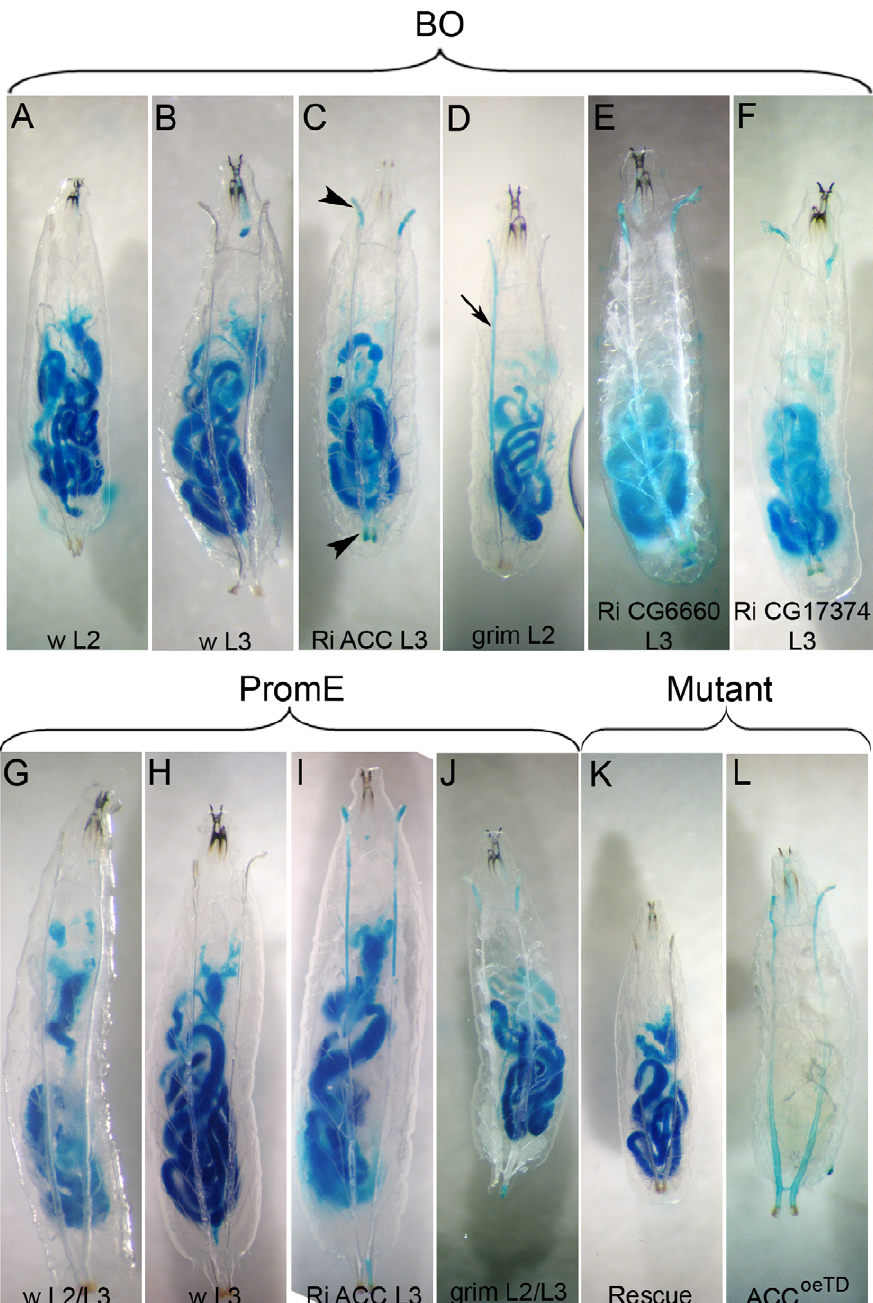
Figure 5. Water-tightness defect of the spiracles. (A–L) Tests for liquid entry into the tracheal system after transfer of larvae onto a semi-liquid media stained with Brilliant Blue FCF. Control larvae were maintained for 36 h inside the tinted feeding medium and analyzed at various times (A,B,G,H,K) Mutant larvae without any visible tracheal defect were transferred onto the tinted feeding medium and analyzed as they strayed away (C,D,E,F,I,J,L). Larvae of the following genotypes and stages: (A) BO control late L2, (B) BO control early L3, (C) BO . ACC-RNAi early L3, (D) BO . grim late L2, (E) BO . CG6660-RNAi early L3, (F) BO . FAS CG17374 -RNAi early L3, (G) promE control at the L2/L3 transition, (H) promE control early L3, (C) promE . ACC-RNAi early L3, (D) promE . grim at the L2/L3 transition, (K) ACC B131 mutant rescue and (L) ACC oeTD . Note that the staining of the gut due to the tinted food is not visible in the hemolymph, which confirms that Brilliant Blue FCF does not easily cross the epithelia. Entry of tinted liquid into the anterior and posterior spiracles (arrowheads in C) and extension into the main trunks (arrow in D) are indicated. Larvae oriented anterior to the top. doi:10.1371/journal.pgen.1002925.g005 homeostasis and in related diseases [38,39]. Metabolic syndrome an RNAi to the ubiquitous FAS gene CG3523 in the FB produced comparable metabolic changes (TR and JM, unpublished results). and type 2 diabetes are associated with increased levels of The metabolism of TGs and glycogen plays a central role in circulating NEFA, TGs, glucose, and with restricted postprandial